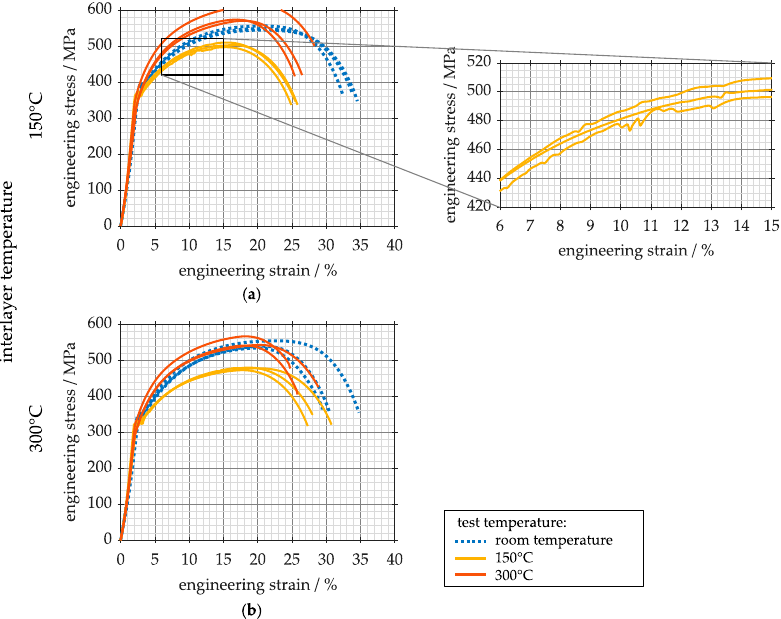
Figure 8. Stress–strain curves (engineering stresses and strains) from monotonic tensile tests for crosswise extraction direction and interlayer temperatures of 150 °C ( a ) and 300 °C ( b ).